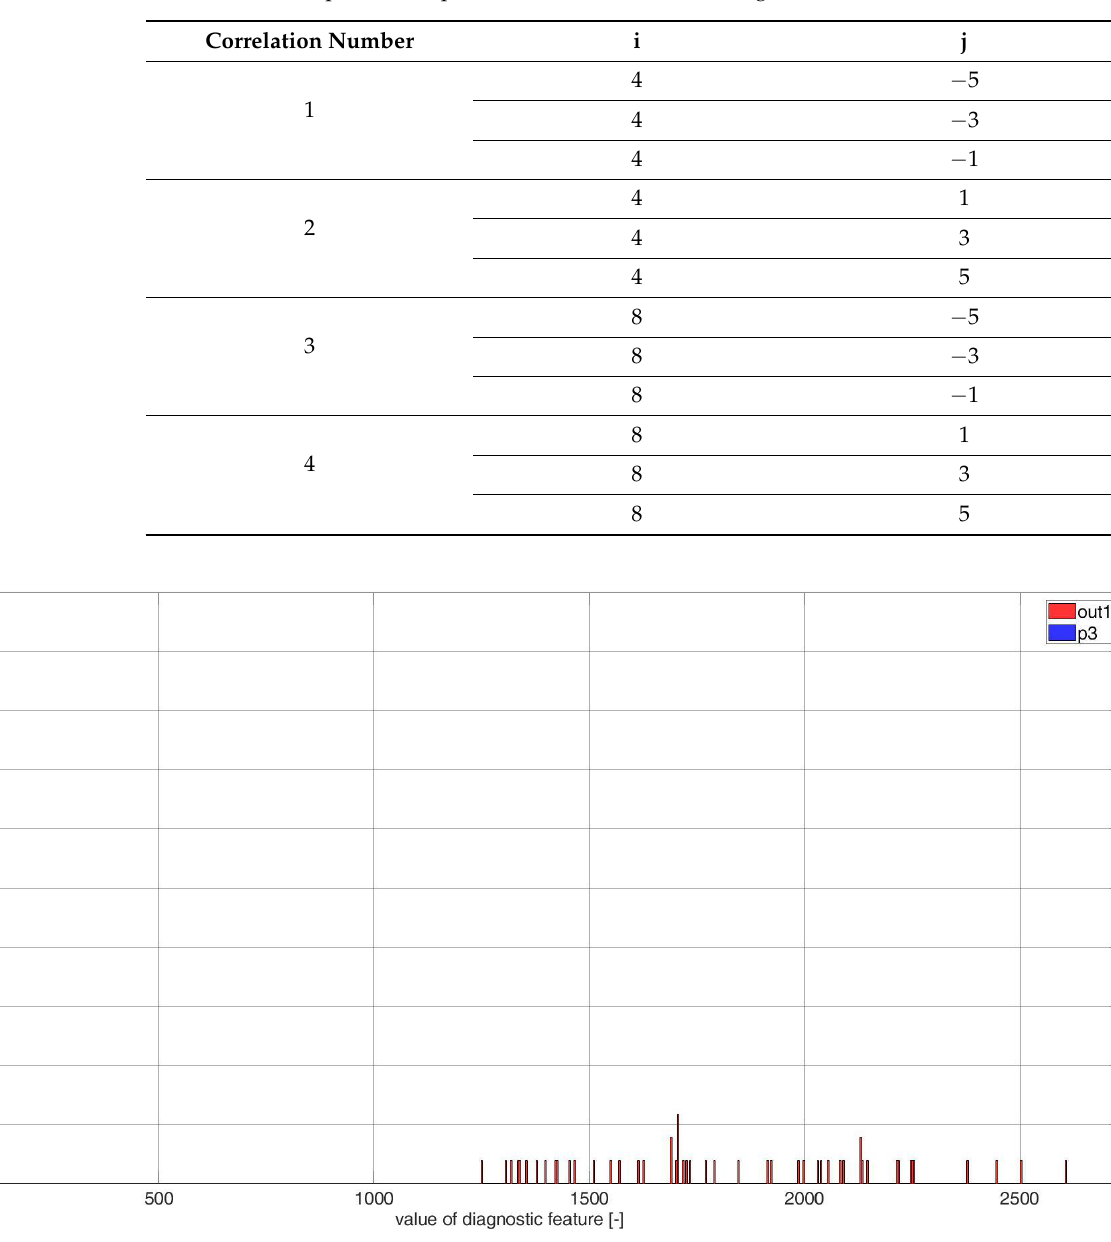
Figure A28. Histograms of diagnostic features based on the CCSM3 (correlation number is 1 — Table A2) bearings out2 and p4.